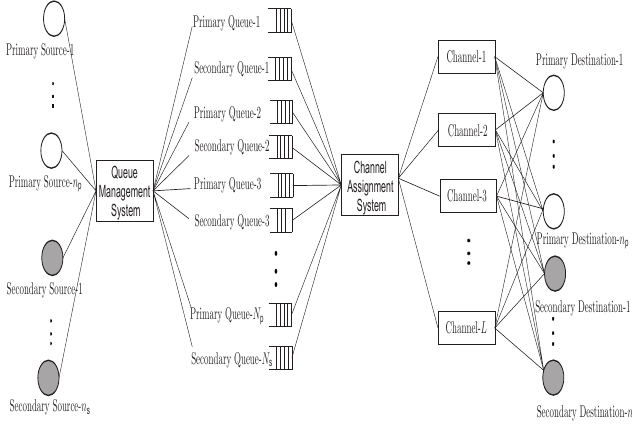
Figure 3. Proposed priority-based queuing model for a context aware multichannel cognitive radio network with multiple primary and secondary